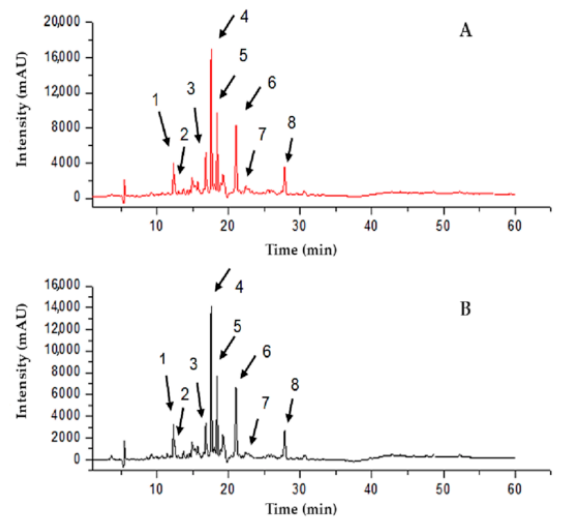
Figure 2. Determination of the markers of red propolis extract (RPE) ( A ) and NPRP ( B ) using UPLC-DAD. Chromatogram of the RPE. 1—Liquiritigenin, 2—Daidzein, 3—Isoliquiritigenin, 4—